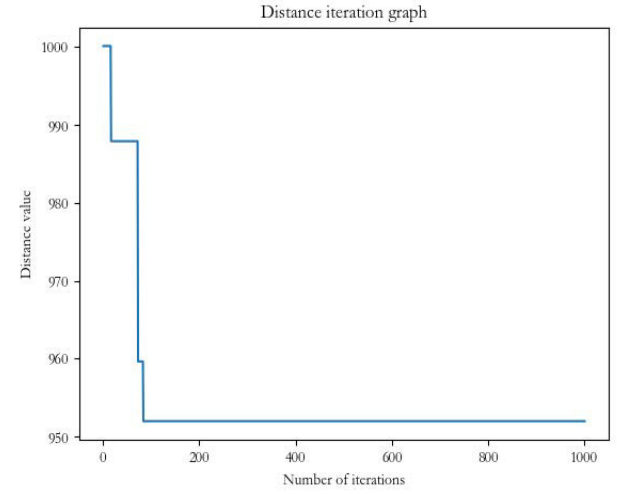
Figure 10. Firefly distance iteration chart.